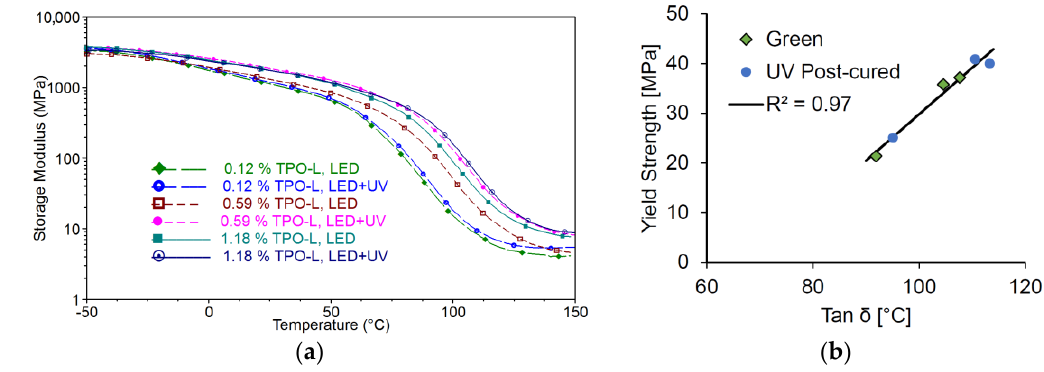
Figure 5. Storage modulus measured by DMA ( a ); and the measured glass transition temperature (tan δ ) compared to the yield strength ( b ).